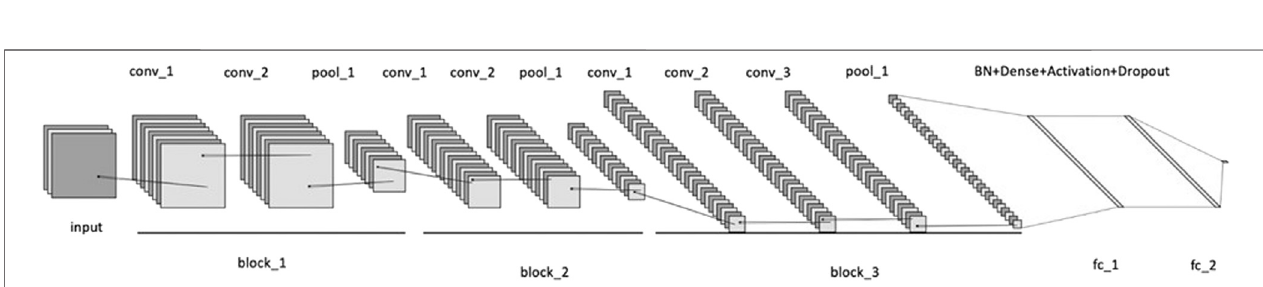
FIGURE 1 | Example of GSV histogram of an inclusion BSE image. The BSE image is displayed on the top left corner.